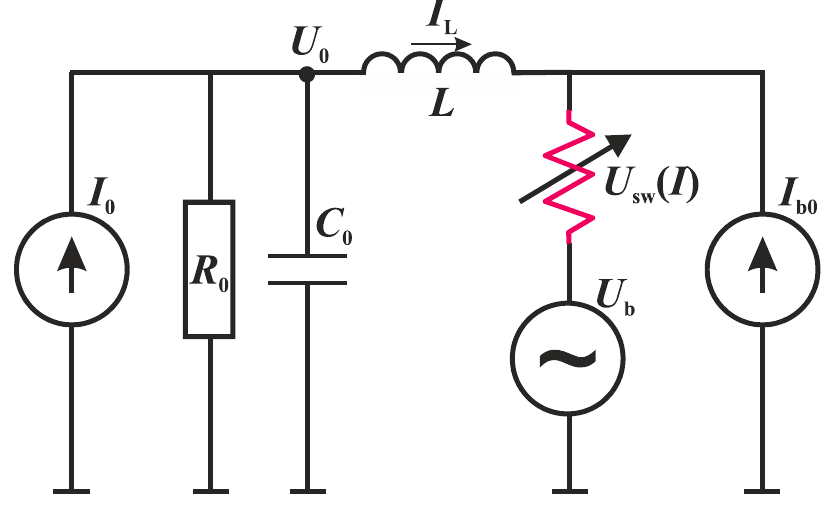
Figure 6. Oscillator circuit implementing the FitzHugh–Nagumo model.